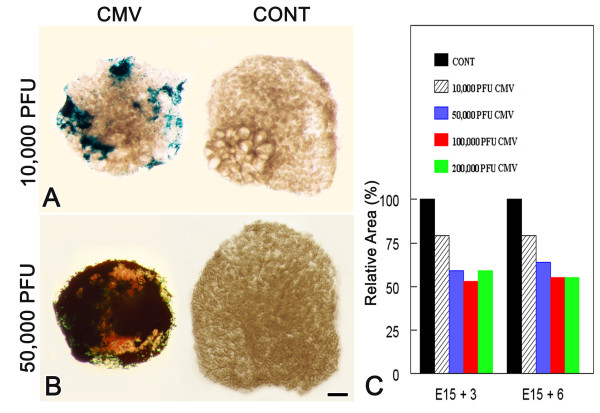
Dose-dependent effect of mCMV-infection on embryonic SMG development. E15+6 SMGs infected with 10,000 PFU mCMV (A) exhibit modest β-gal staining (viral presence) in the periphery, whereas SMGs infected with 50,000 PFU mCMV (B) exhibit staining almost completely throughout the gland. No β-gal staining is seen in control (CONT) SMGs. Bar:50 μm C. Relative to controls, there are significant (P < 0.01) declines in the size of mCMV-infected SMGs (as measured by area); this decline is dose dependent (P < 0.01). Comparisons of control and infected SMGs were based on matched pairs (right v. left in the same embryo). Samples sizes for each bar ranged from 6 to 29 matched pairs. True differences were determined by matched-pairs t-test. See text for details.